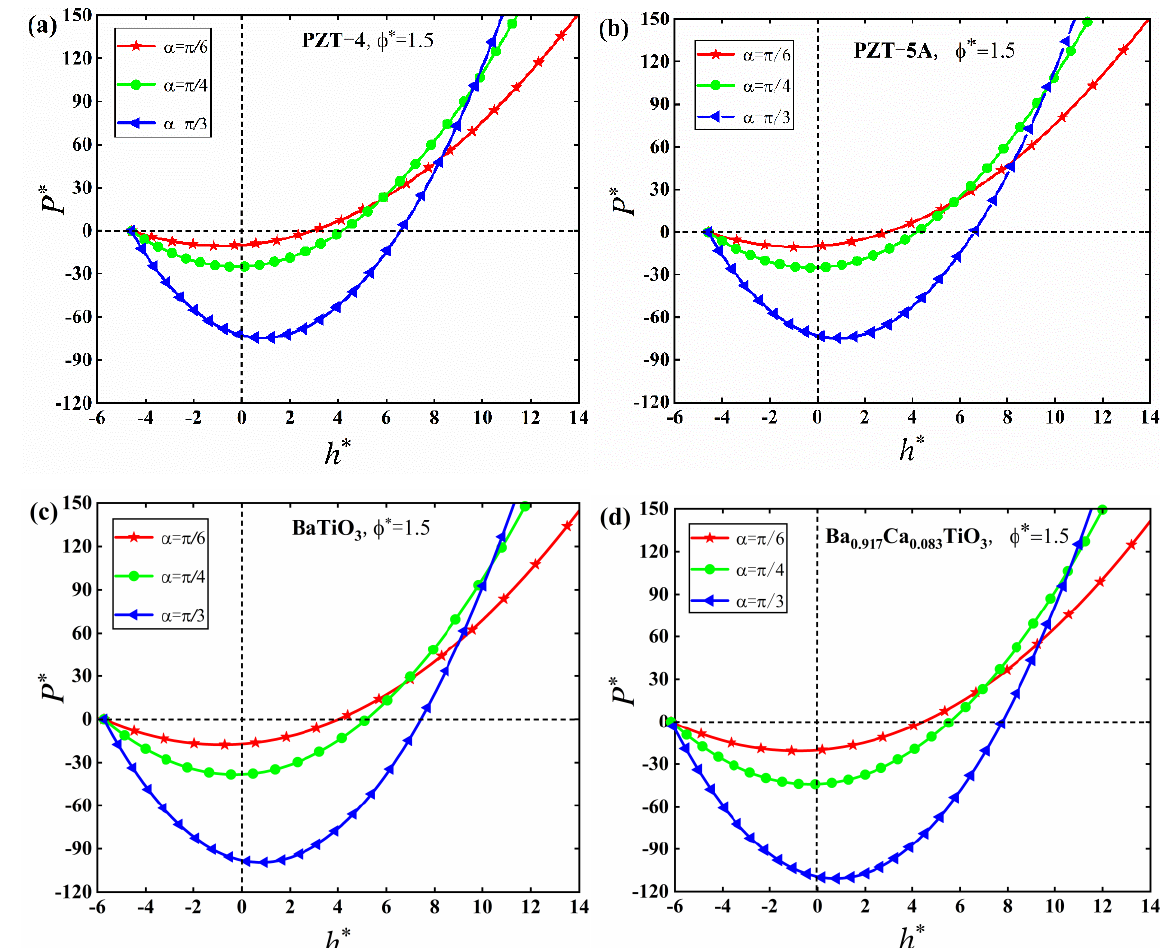
Figure 8. The dimensionless indentation force, P ∗ , as a function of the dimensionless indentation, h ∗ , at the different values of α = π /6, π /4 and π /3 for the conducting punch with non-zero electric potential ( φ ∗ = 1.5). ( a ) PZT-4. ( b ) PZT-5A. ( c ) BaTiO 3 . ( d ) Ba 0.917 Ca 0.083 TiO 3